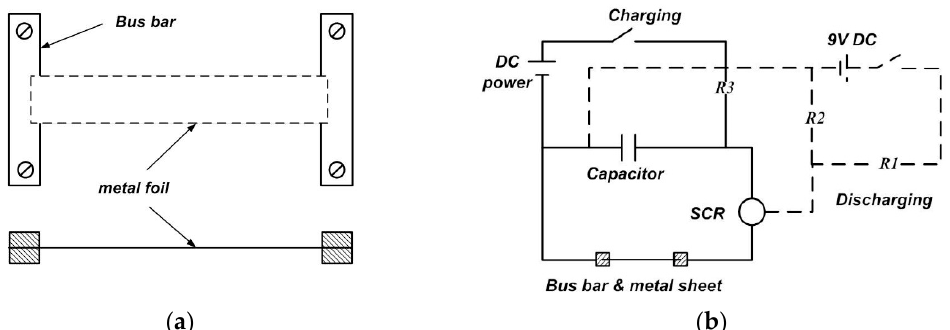
Figure 1. The experimental chamber and circuit diagram [31]. ( a ) Modeled chamber, ( b ) Circuit diagram of resistance–capacitance (R–C) heating.